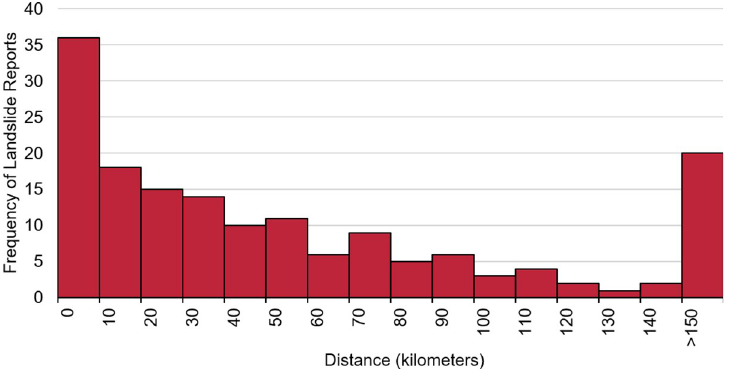
Fig 7. Distance to the nearest GLC landslide event. The histogram illustrates the distance of each LRC landslide event to the nearest GLC event in the repository in bins of 10 km. The last bin contains all distances greater than 150 km to the nearest GLC event.